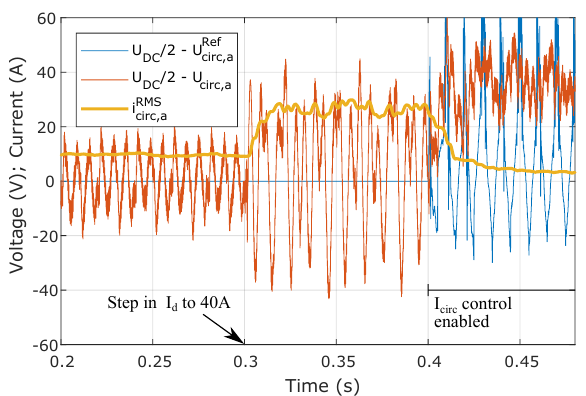
Figure 8. Mismatch between u circ and its reference. As a consequence, an estimation of i circ based on the references delivers poor